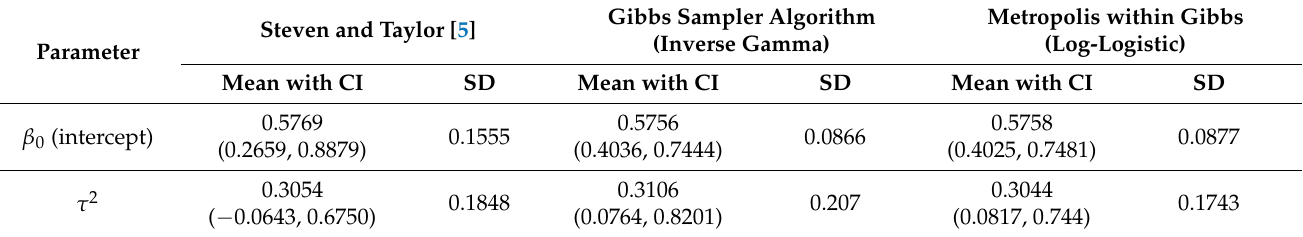
Table 11. Parameter estimates  0 (intercept) and  2 given by Stevens and Taylor [5] ; obtained by the use of the Gibbs sampler algorithm and by the use of the Metropolis within Gibbs (case study).